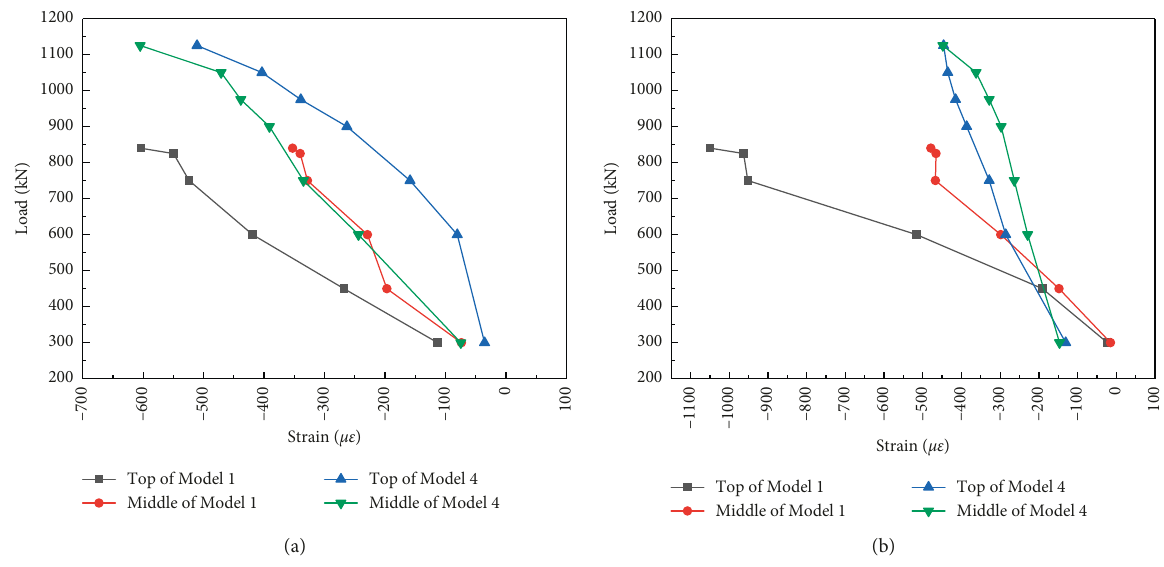
Figure 27: Load-strain curves of vertical rods in Models 1 and 4. (a) Comparison of A3 rod. (b) Comparison of C3